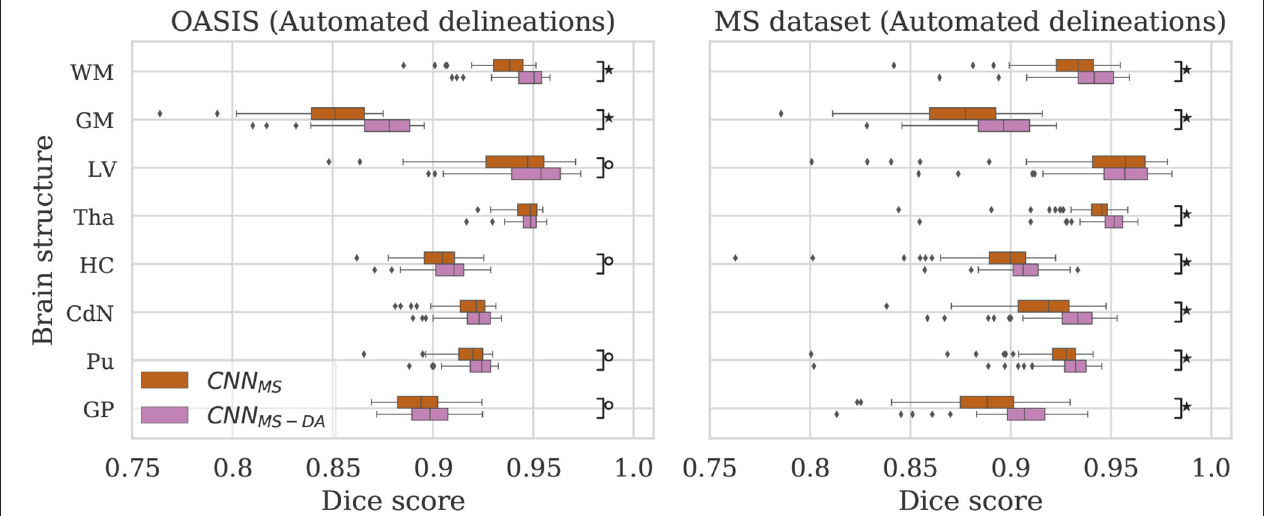
FIGURE 4 | Dice scores for the CNN MS and CNN MS - DA models on the OASIS (left) and MS dataset (right) test sets. Marks indicate that there is a significant difference between the two models (Wilcoxon, ◦ p < 0.05, ⋆ p < 5 × 10 − 4 ).